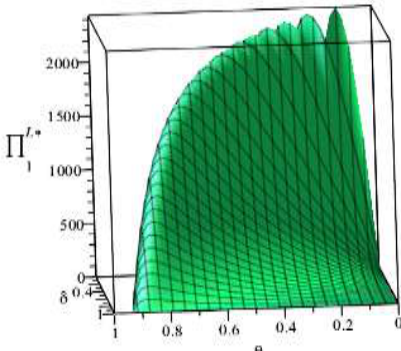
Figure 8. E ff ect of manufacturer’s behavior θ , δ on logistics network under performance. Figure 8. Effect of manufacturer’s behavior 𝜃 , 𝛿 on logistics network under performance.